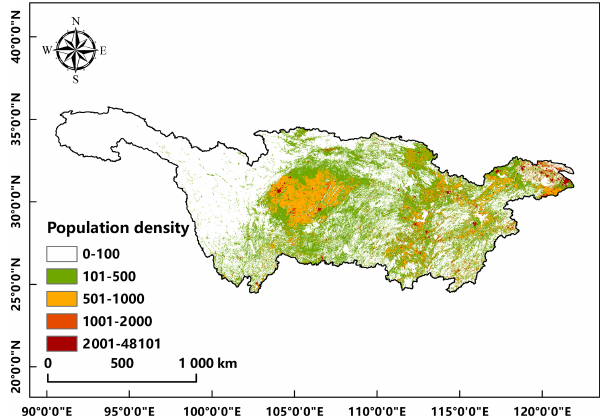
Figure 8. The spatial distributions of grids where the population density is greater than 100 per km 2